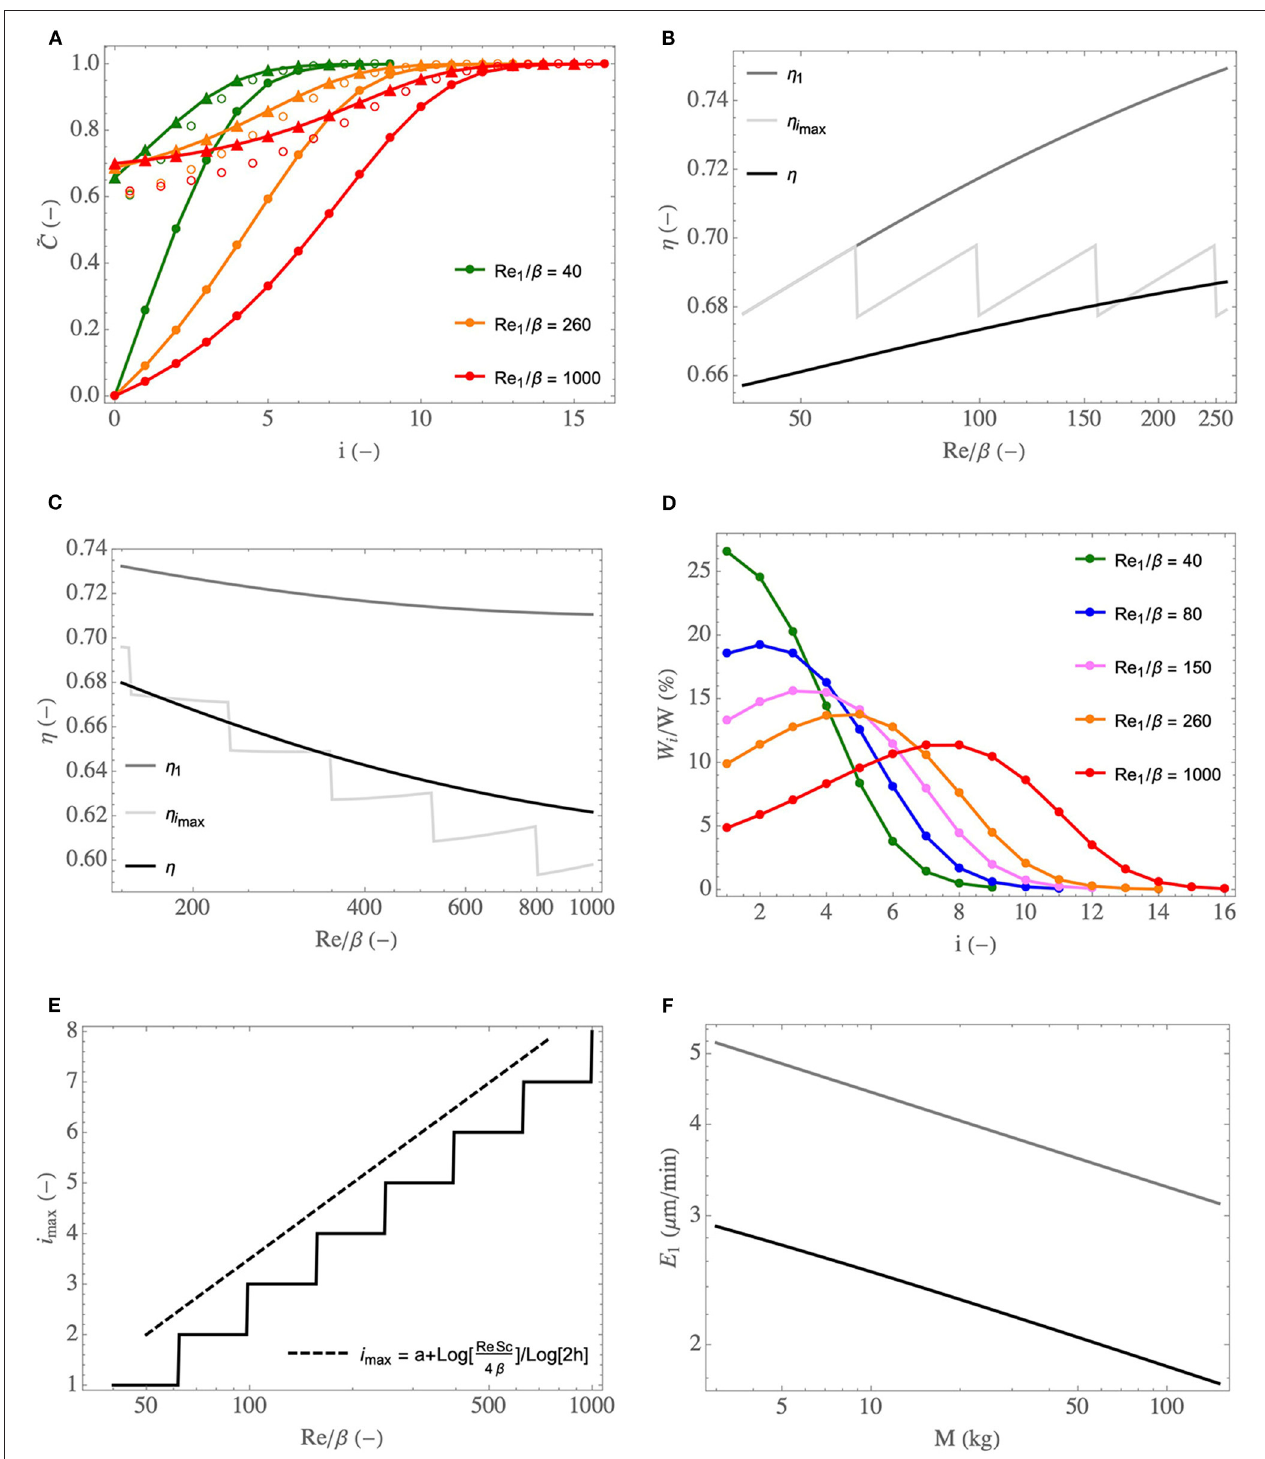
FIGURE 7 | (A) Dimensionless water concentration profiles in the lumen, during inspiration (full circles) and expiration (triangles), for different Re insp 1 /β and for φ/ψ 1. (C) idem but with φ/ψ progressively decreasing with an increase of as functions of Re insp 1 /β , for φ/ψ 1. Empty circles: values of ˜ C µ , i . (B) η , η 1 , and η i max = = 1. (E) Index of the generation in which the maximal amount Re insp 1 /β , to simulate an increasing effort. (D) W i / W as a function of i , for different Re insp 1 /β and for φ/ψ = 1 (full line curve), and the scaling law (dashed curve). (F) E 1 as a function of M , at rest (black curve) and of water is extracted as a function of Re insp 1 /β and for φ/ψ = during an effort (gray curve, calculated with ψ 6 and φ = =